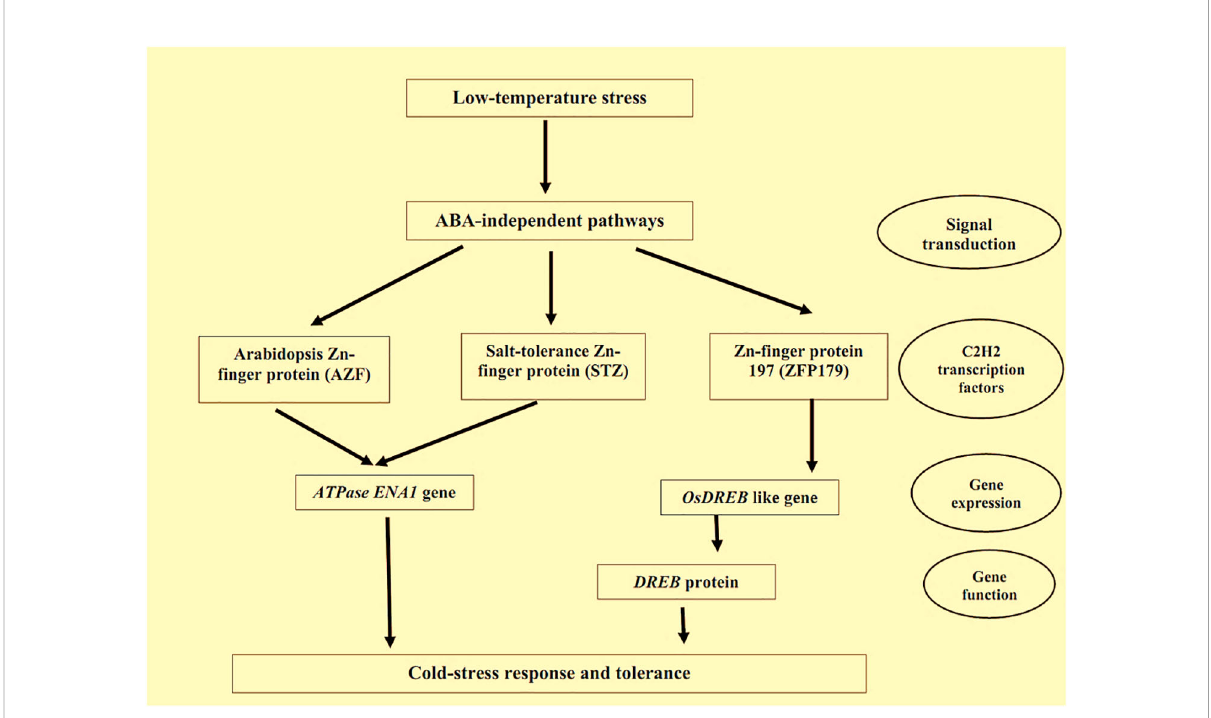
FIGURE 4 ABA-independent pathways for cold-tolerance by C2H2 Zn- fi nger proteins. Note: Zn- fi nger proteins also regulate the several pathways of plants under heat-induced stresses. Huang et al. (2008) found A20/AN1-type Zn- fi nger proteins in japonica rice regulating the heat-induced stresses in the plants. Moreover, they reported that Zn- fi nger protein, ZFP177 was responsive to heat stress tolerance in plants. Overexpression of Zn- fi nger protein, ZFP177, is also responsible for the heat tolerance in tobacco plants (Mukhopadhyay et al.,